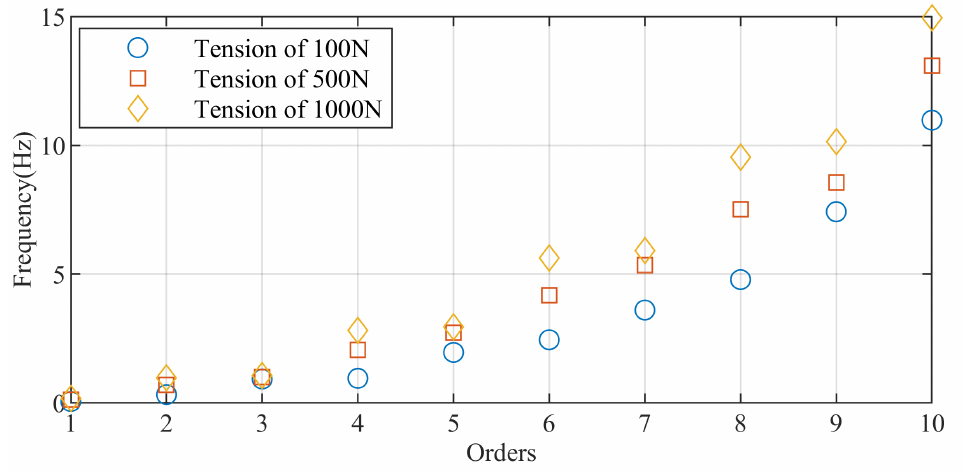
Figure 9. The 1 ∼ 10-order frequencies of the manipulator system under different